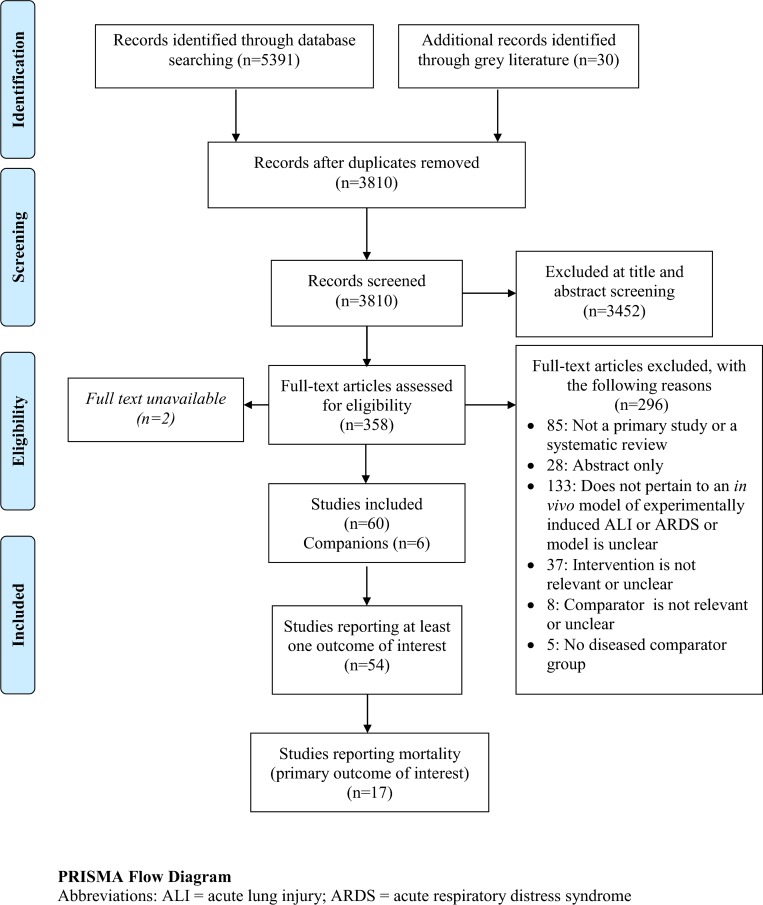
PRISMA flow diagram.